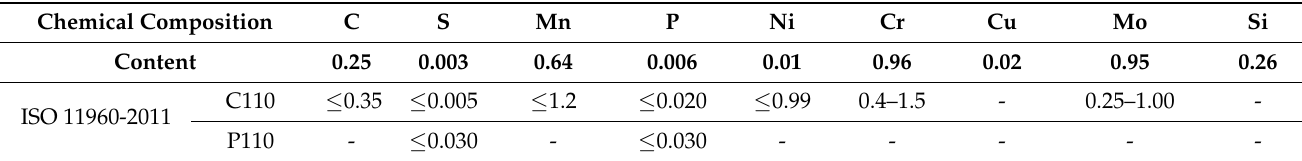
Table 1. Chemical composition of failed tubing